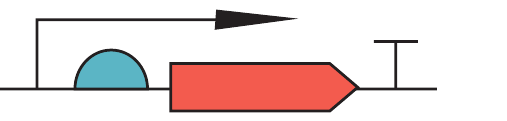
Figure 12: Example of incorrect glyph overlap: promoter (arrow) does not overlap in sequence with the ribosome entry site and CDS, so SHOULD NOT overlap visually with